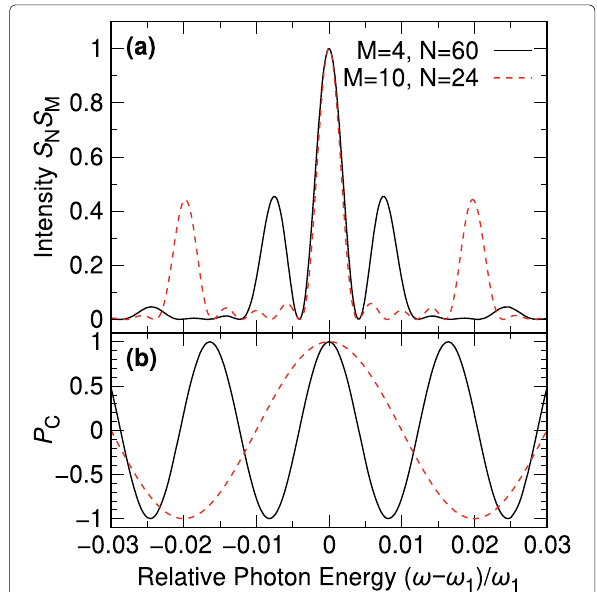
Fig. 3 Properties of undulator radiation from an ideal SCU. a Energy spectra and b degree of CP, P C calculated for ϕ 1 = ϕ 2 =2 π and different M and N